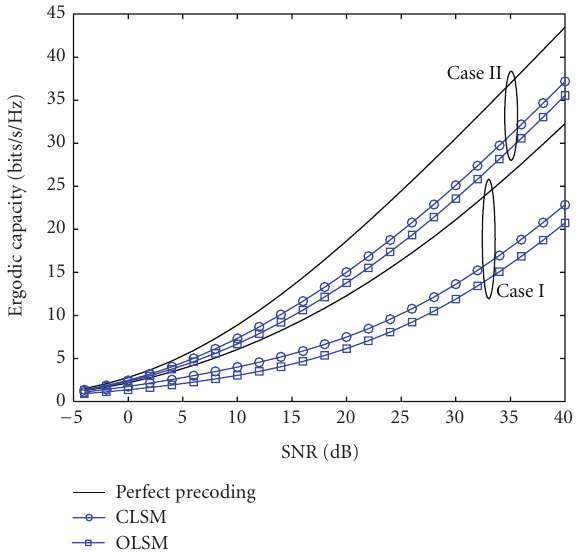
Figure 8: Capacity comparison between CLSM and OLSM for L4 transmission with MMSE receiver.